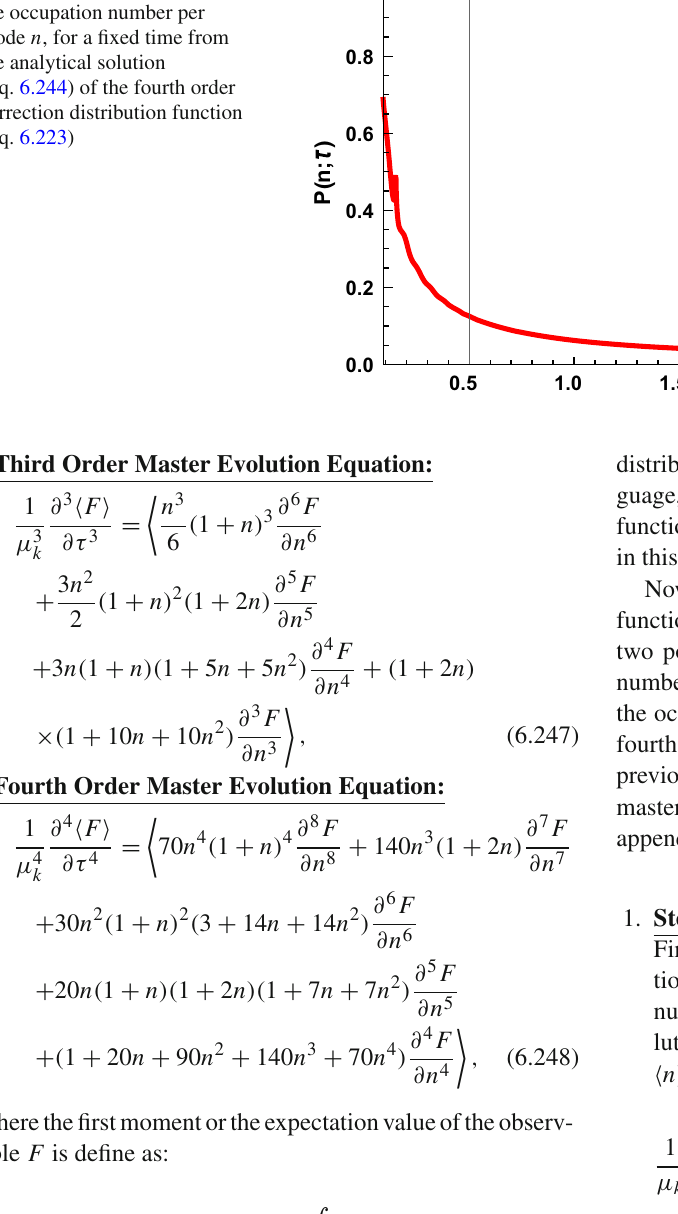
Fig. 44 Fourth order contribution to the probability density function with respect to the occupation number per mode n , for a fixed time from the analytical solution (Eq. 6.244) of the fourth order correction distribution function (Eq.